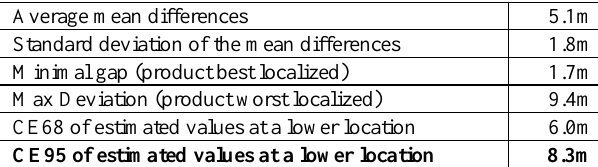
Table 1. Geolocation performances statistics on Australian